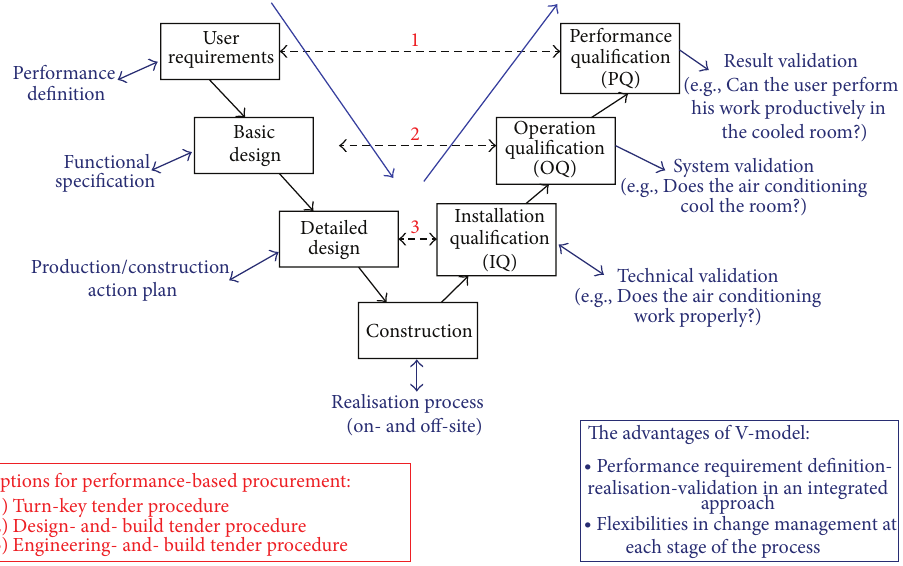
Figure 2: Proposed V-model for performance-based procurement (adapted from